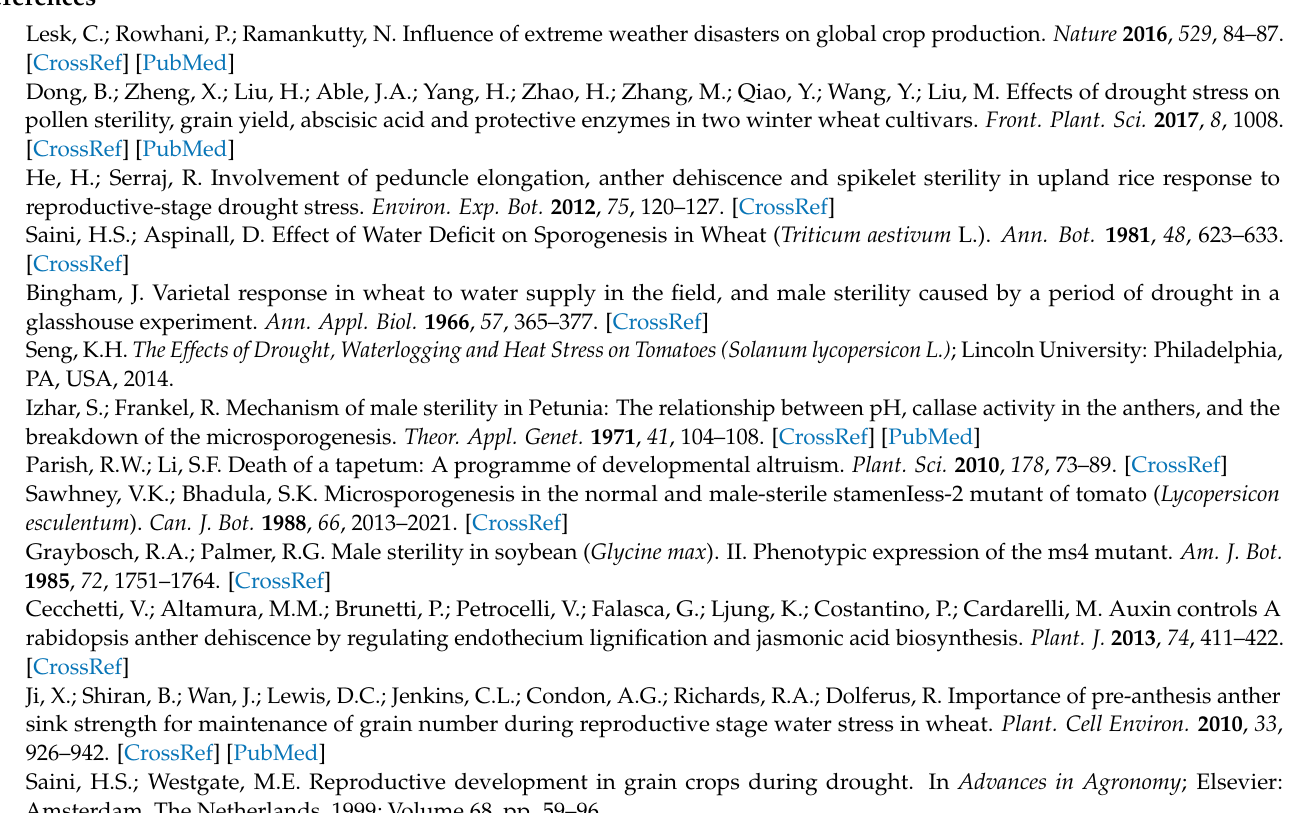
Table S7: GO terms significantly enriched in DEGs down-regulated by drought stress in tomato anthers, Table S8: Significantly enriched KEGG pathways in drought responsive genes of three groups of anthers under drought stress in tomato, Table S9: DEGs involved in the tapetum and microspre development in tomato, Table S10: Drought regulated DEGs involved in starch and sucrose metabolism in tomato anthers, Table S11: Drought regulated DEGs involved Plant hormone metabolic process and signaling in tomato